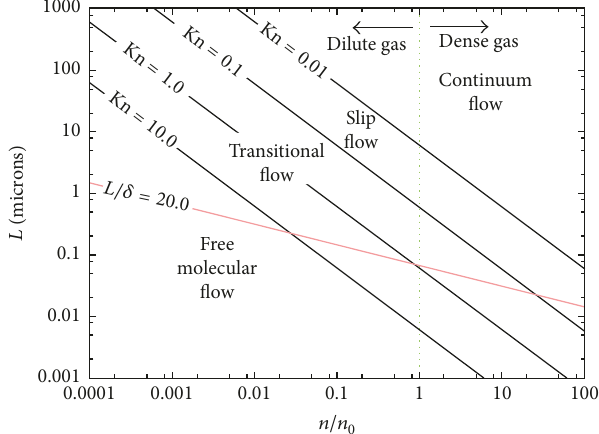
Figure 8: Flow categories with the increase in Knudsen number (https://wikiversity.org/). In this Figure, 𝐿 is the characteristic wetted length of the domain under investigation, 𝛿 is the mean molecular spacing, 𝑛 is the number density of the gas, and 𝑛 0 is the number density of the gas at 0 ∘ C and